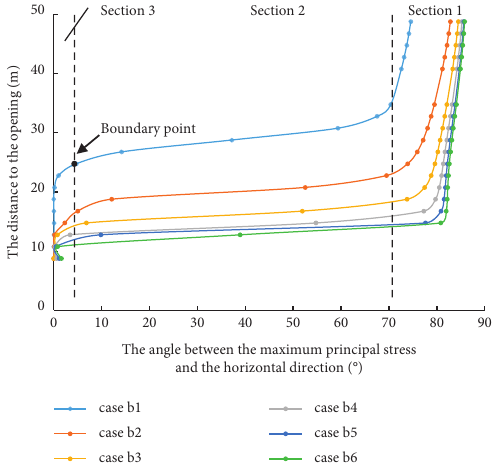
Figure 8: The relationship between the direction of the maximum principal stress and the distance to the